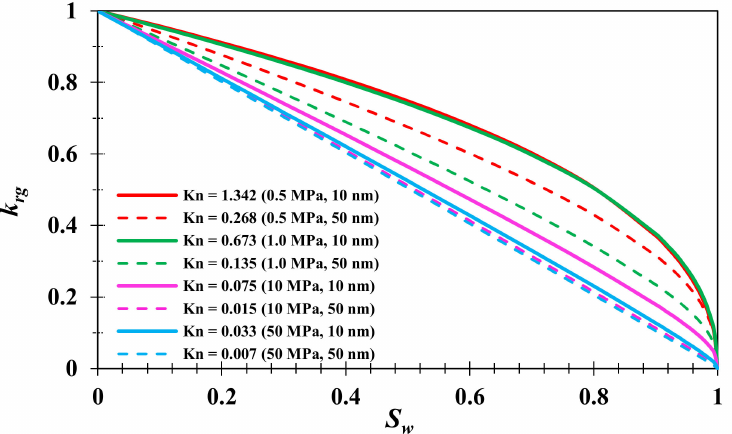
Figure 10. Relative permeability curves with different Knudsen numbers (circular pore model).